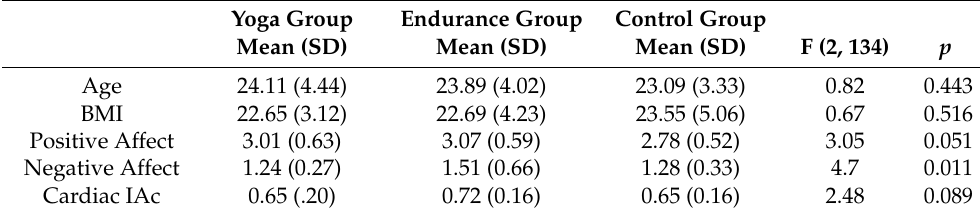
Table 1. Descriptive statistics at baseline per group.